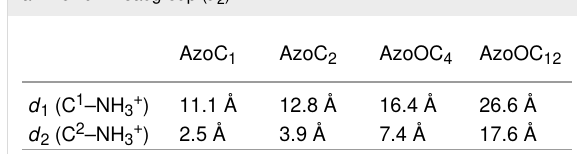
Table 1: Determination of the length of the azobenzene ligands ( d 1 ) and the length of the spacer between the azobenzene moiety and the